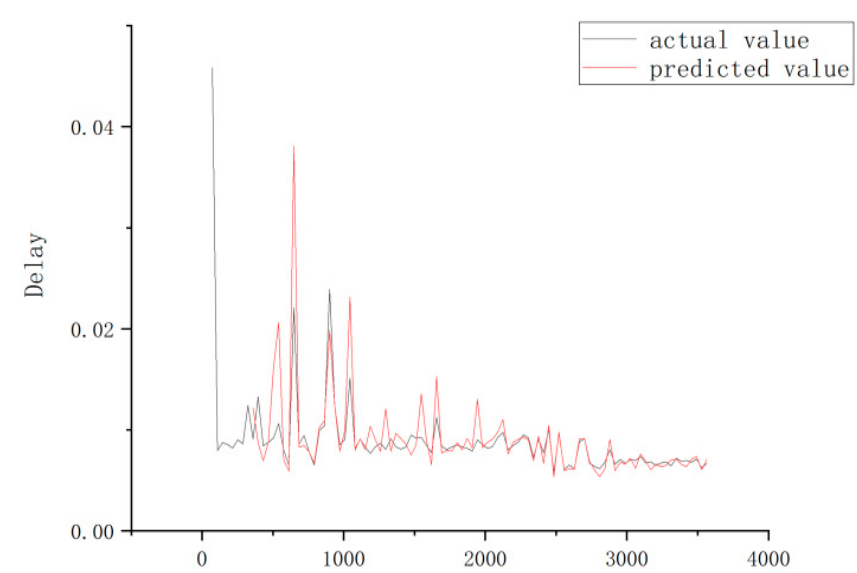
Figure 22. Comparison of the actual and predicted values.